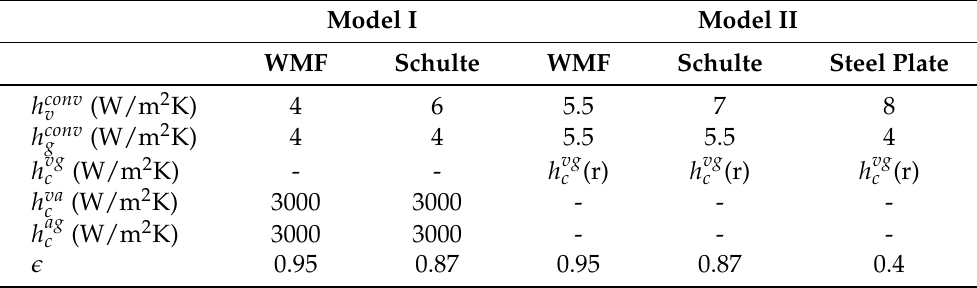
Table 3. Heat loss coefficients: convective coefficients ( h conv v and h conv g ), thermal conductance coeffi- cients ( h vg c , h va c and h ag c ) and emissivity coefficient ( (cid:101) ) for the five FE models, the two with the layer of air (Model I) and the three with the non-linear thermal conductance along the radius (Model II).